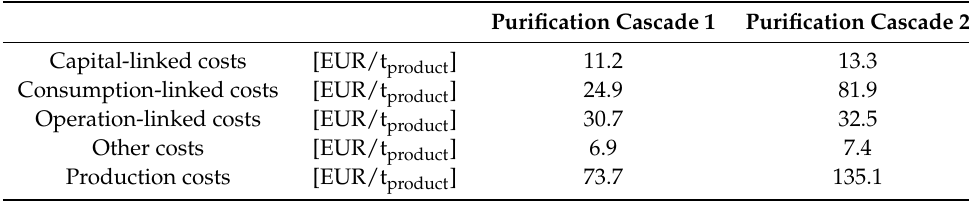
Table 7. Specific production costs of the purified xylose and hemicellulose